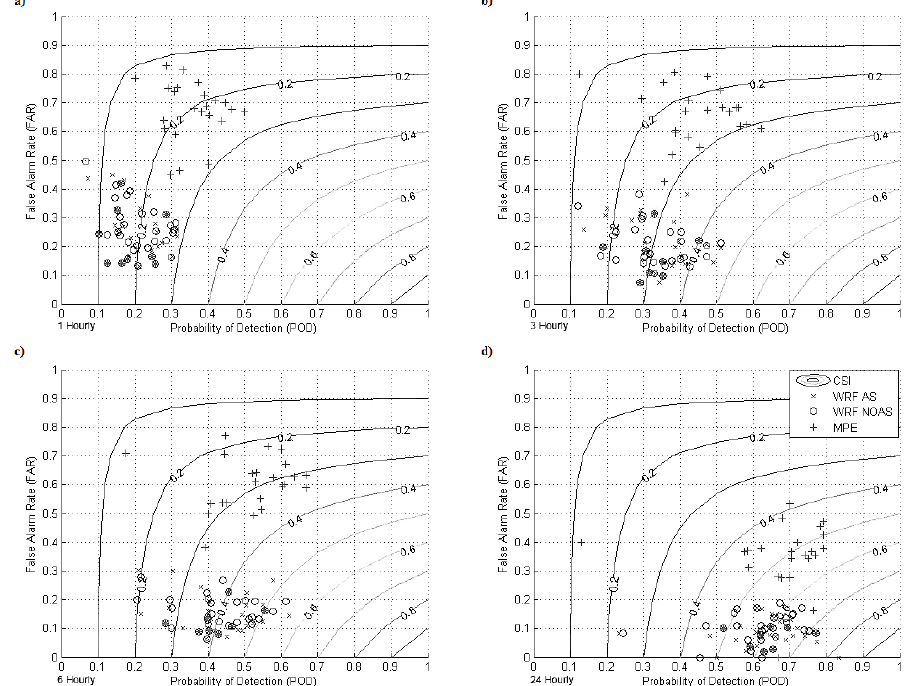
Fig. 9. POD, FAR and CSI statistics of WRF AS, WRF NOAS and MPE are shown together for each of the 34 stations at 1, 3, 6, and 24h intervals in (a) , (b) , (c) , and (d) ,